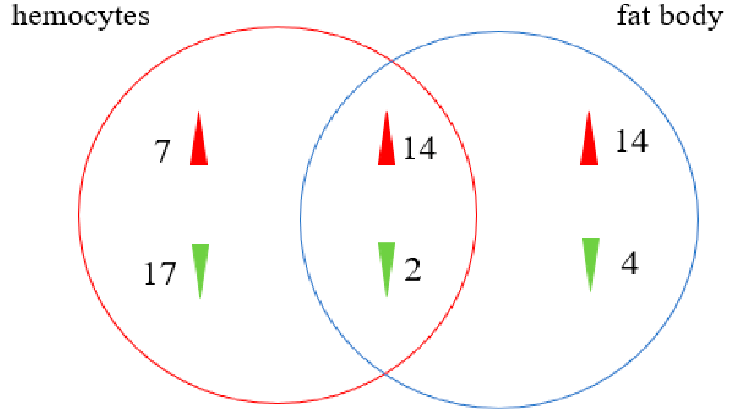
Figure 7. Distribution of E. oblique immunity-related genes in the categories of pathogen recognition, signal modulation, signal transduction (Toll, IMD, JNK, and JAK/STAT pathways), and immune.